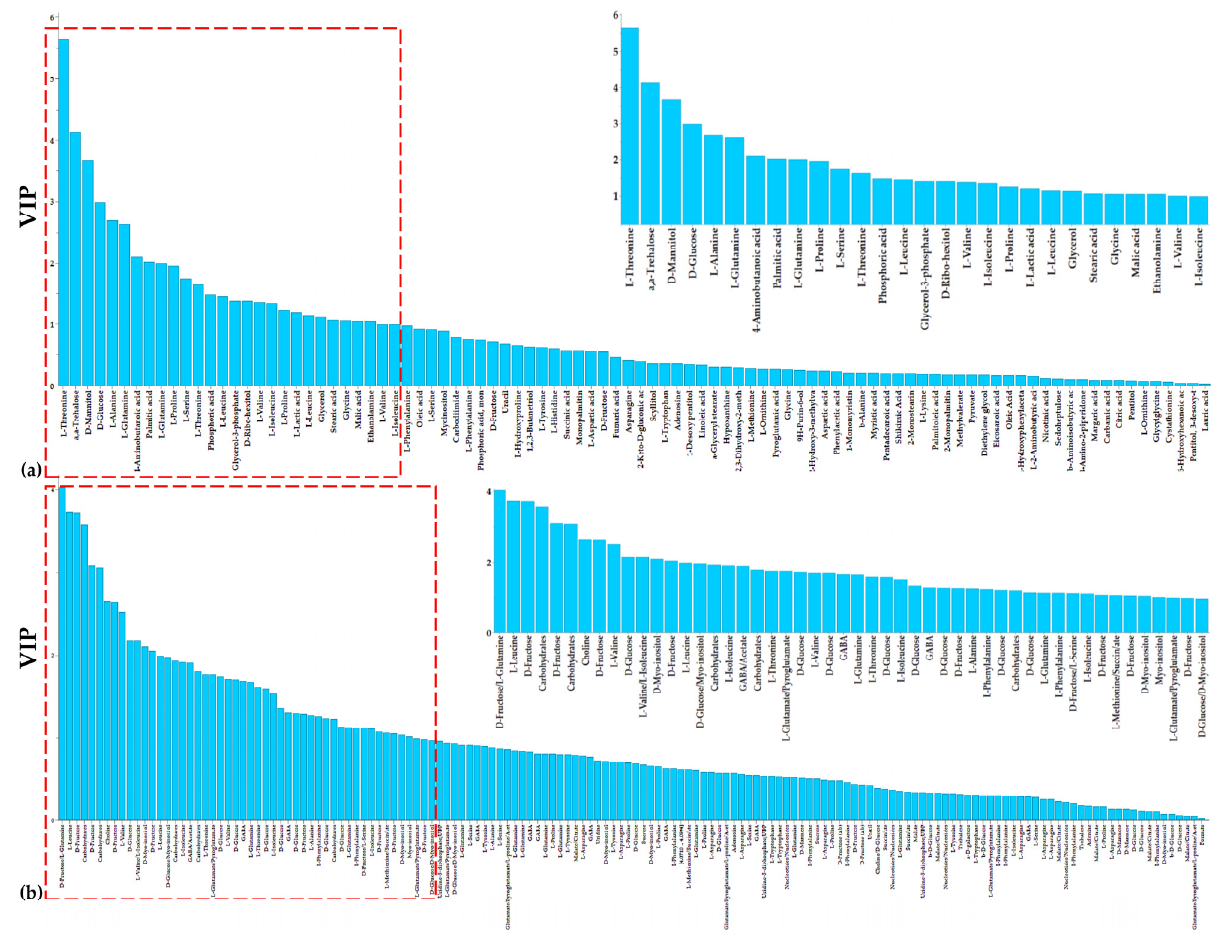
Figure 6. Variable in fl uence on projection (VIP) plots with the VIP values of the Colletotrichum acutatum metabolites performing ( a ) GC/EI/MS and ( b ) 1 H NMR metabolomics. The metabolite pro fi les of the fungus were recorded 17 days following treatments with olive tree endophytic Bacillus sp. lipopeptide extract. High VIP values correspond to the most in fl uential metabolites to the observed discrimination between the untreated and LP-treated fungal cultures. Magni fi cation of the red dashed areas of the plots is displayed on the right upper panels.